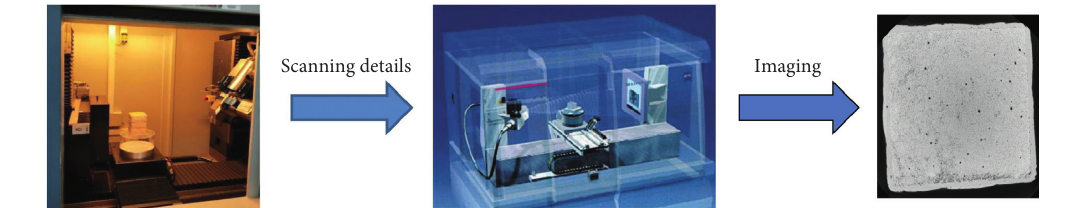
Figure 3: Internal structure and scanning principle of the compact-225 industrial CT.